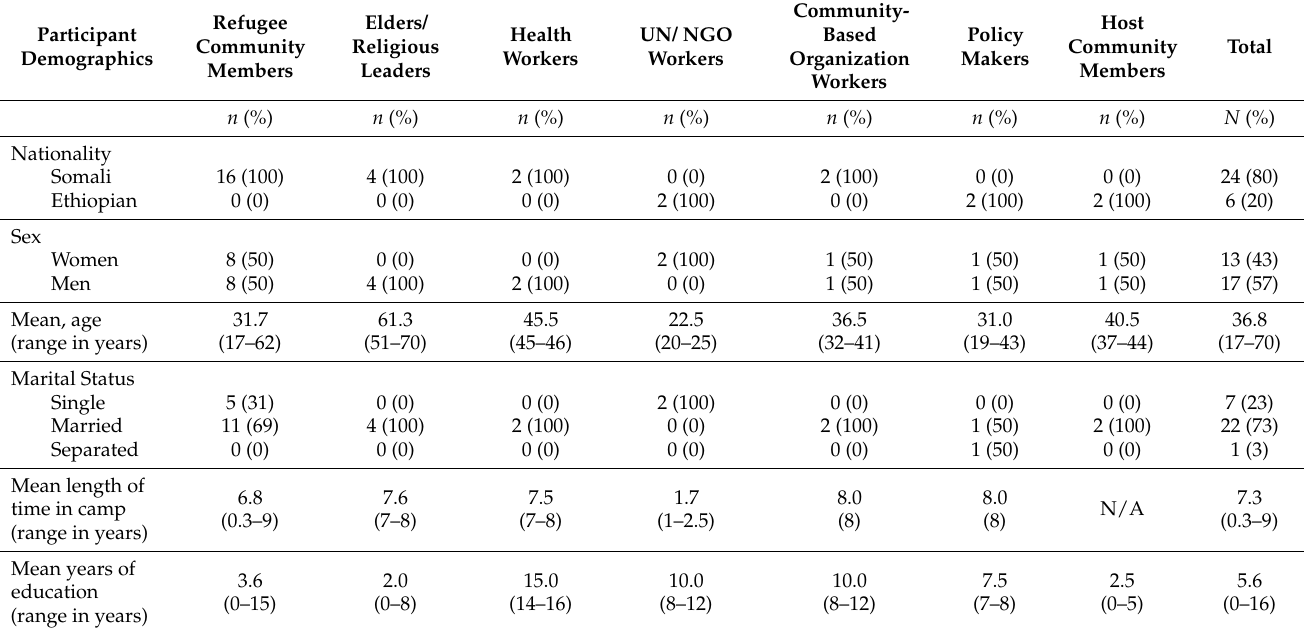
Table 1. Study participant